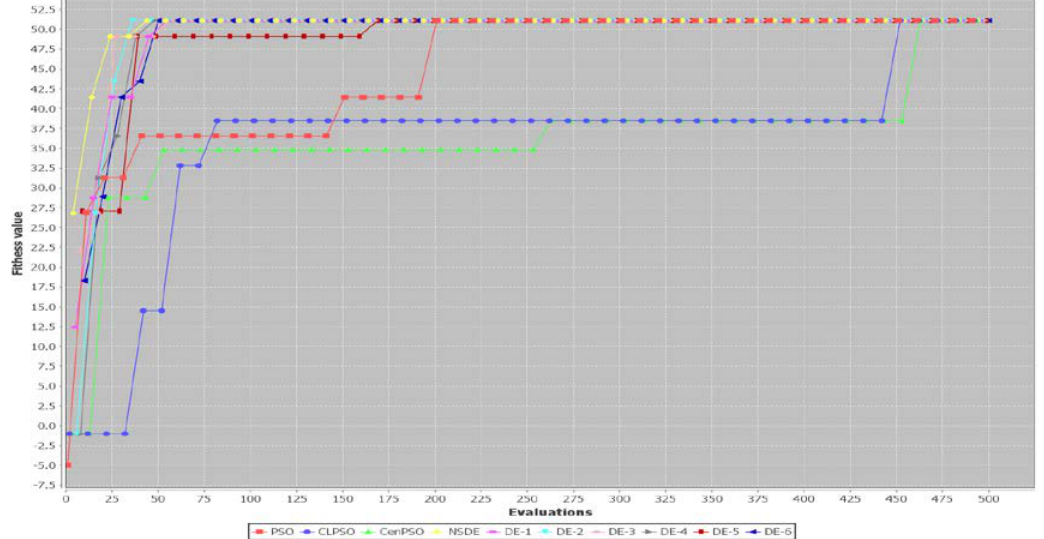
Figure A4. Convergence speed of a run of each algorithm for Case 4 with POP = 30.